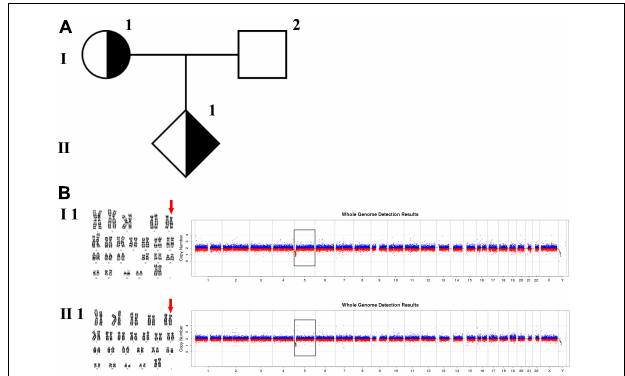
FIGURE 1 | Karyotyping and CNV-seq results of family 1. (A) The pedigree of the family 1. (B) Karyotyping and CNV-seq results of the pregnant woman (I-1) and amniotic fluid (II-1). The red arrow indicates the deletion of 5p in karyotyping results. The box indicates the deletion of 5p in CNV-seq results.